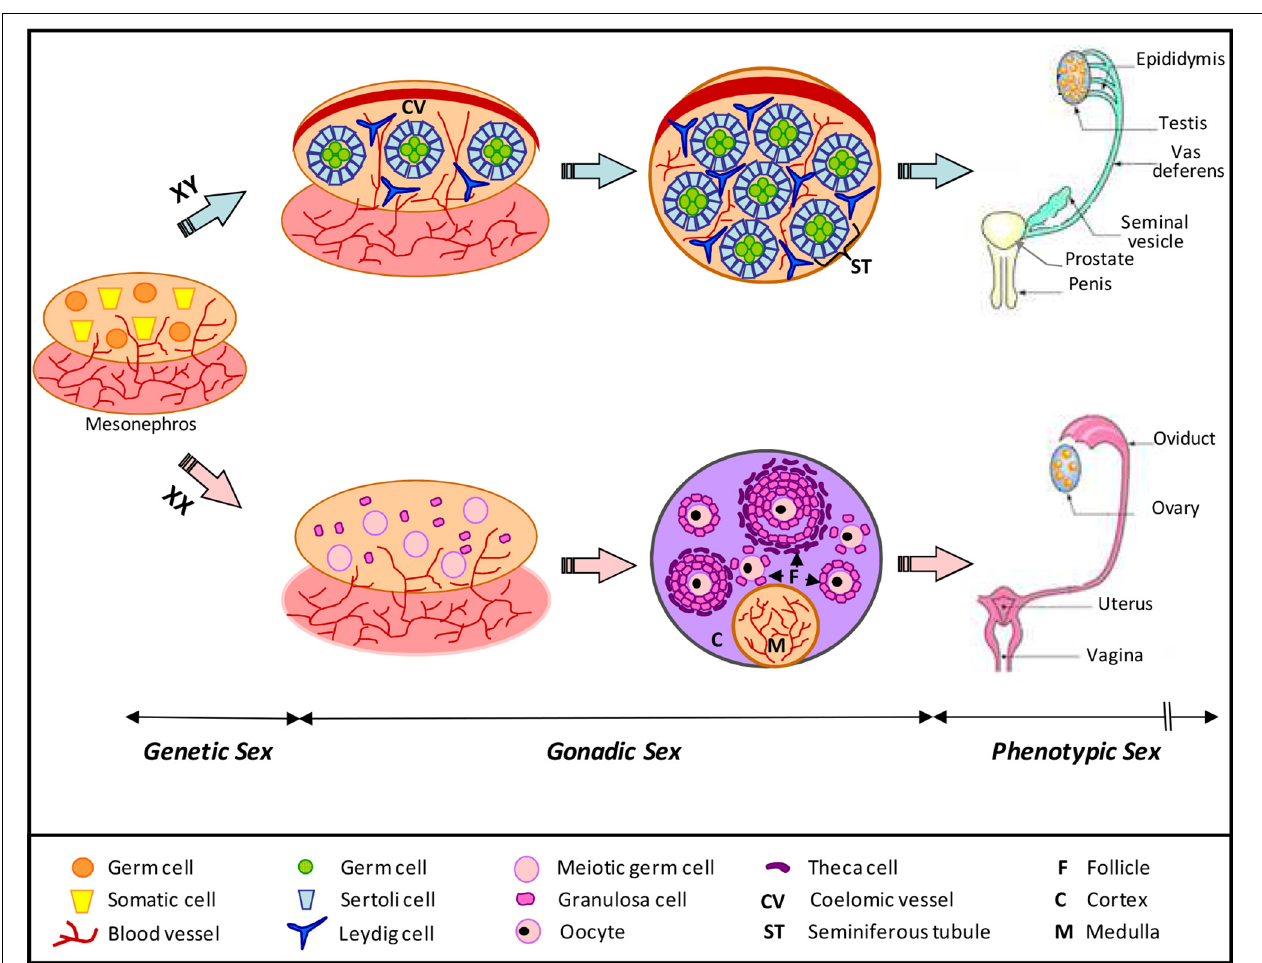
FIGURE 1 | Schematic representation of mammalian gonad differentiation. The genetic sex directs the development of the bipotential gonad toward a male or female gonadal fate. Three cellular types are present in differentiating gonad: somatic supporting cells, somatic steroid-producing cells, and germinal cells. Male and female somatic supporting cells have a common origin and differentiate respectively in Sertoli and granulosa cells. Steroidogenic cells will differentiate in Leydig cells in testis and theca cells in ovary. Testicular-specific features include the formation of the coelomic